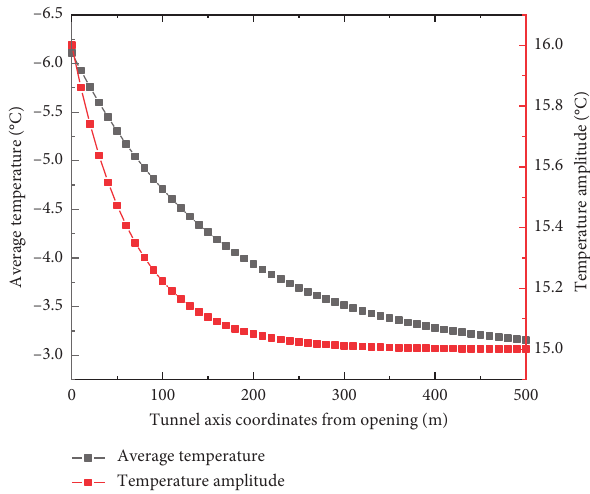
Figure 9: Longitudinal distribution curve of the average tem- perature and temperature amplitude in a